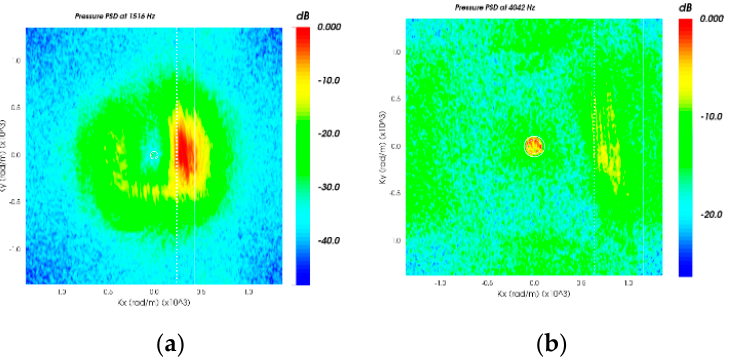
Figure 24. Wavenumber diagrams at different frequencies: ( a ) 1516 Hz; ( b ) 4042 Hz.